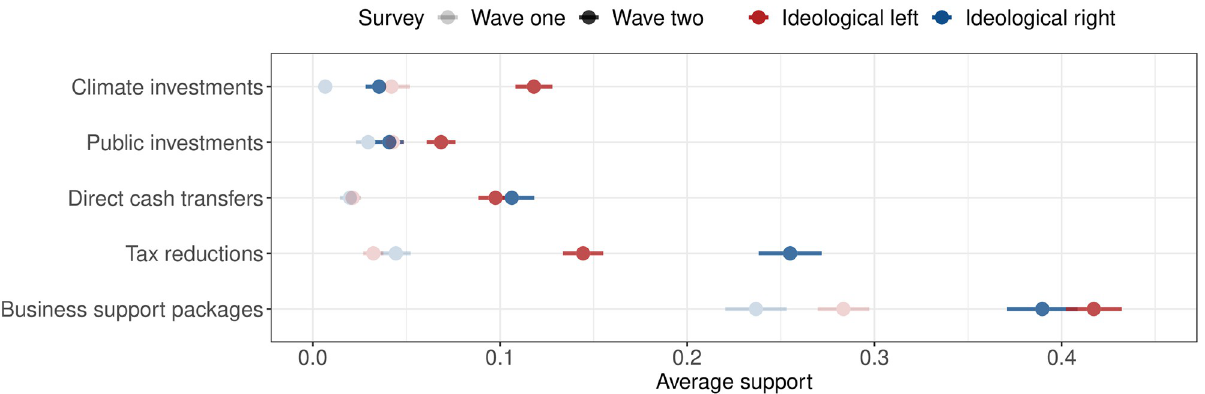
Fig 5. Support for different state interventions across ideology. Lines are 95% confidence